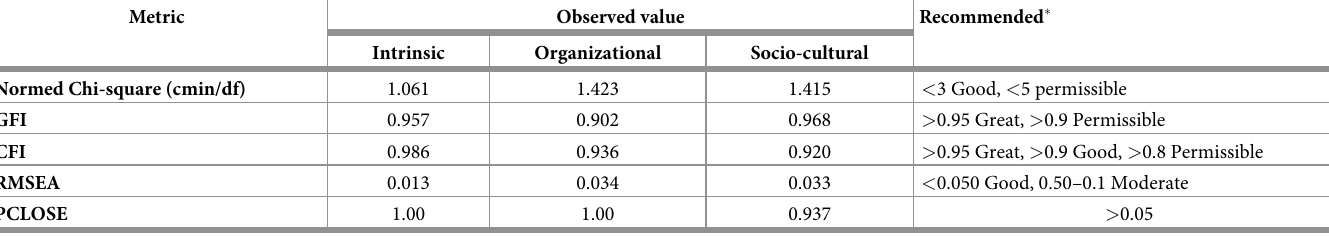
Table 4. Fit indexes for intrinsic, organizational & socio-cultural